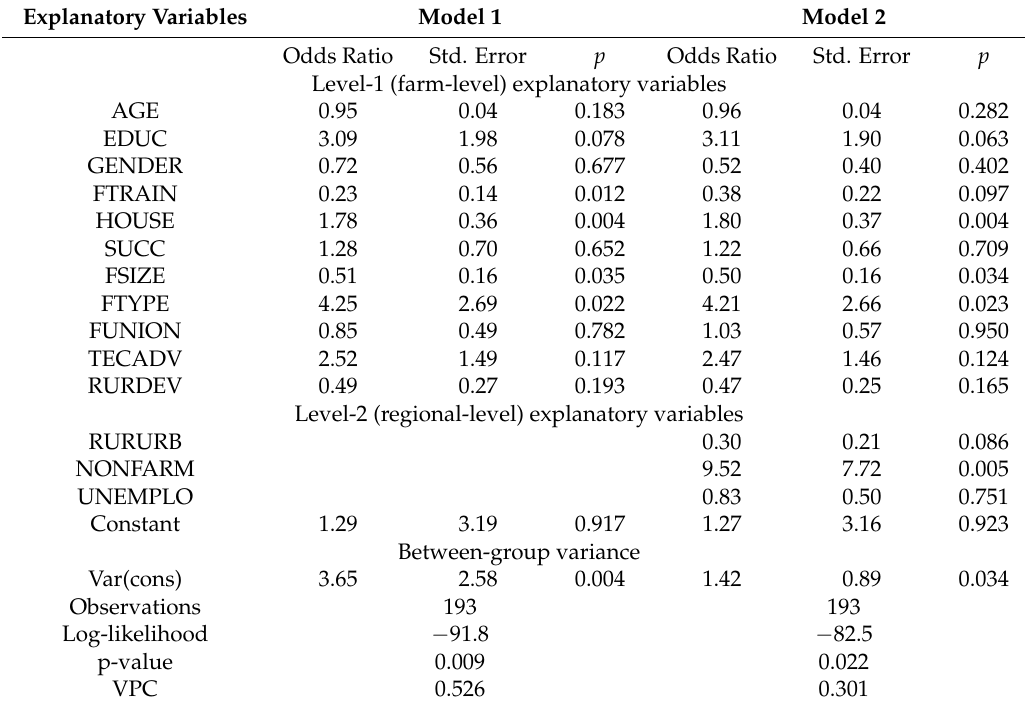
Table 3. Multilevel logistic regression odds ratios and significance of farm-level and regional-level determinants of off-farm